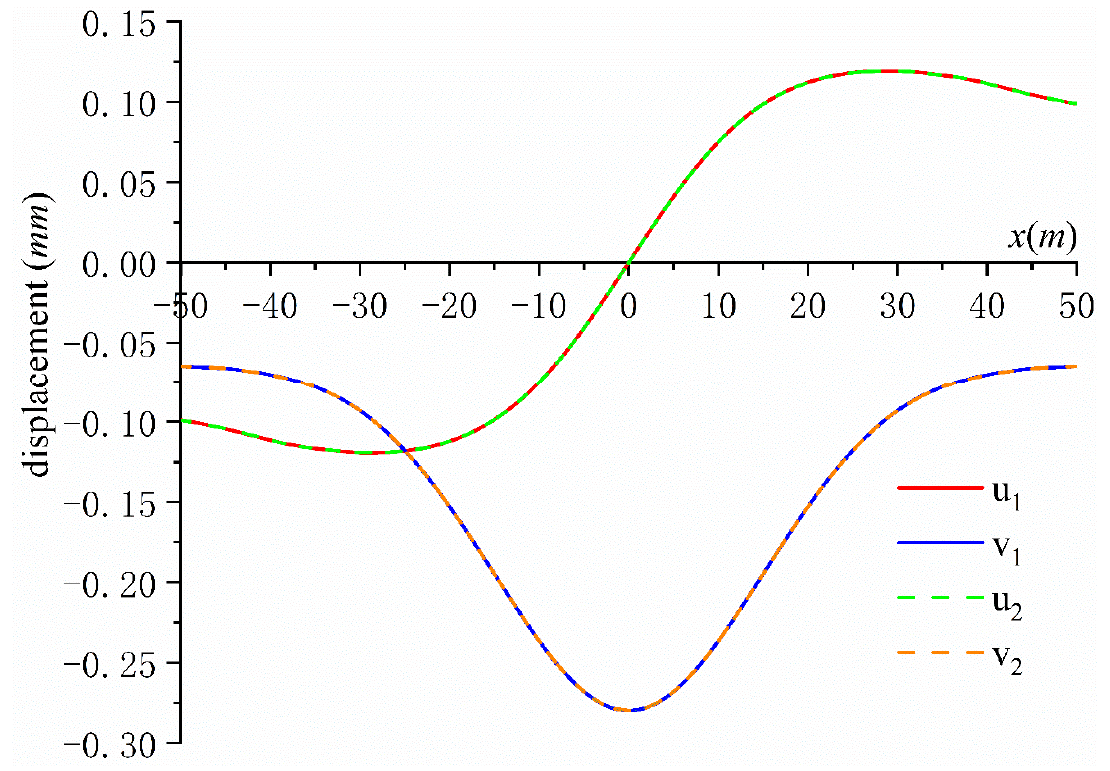
Figure 3. Verification of displacement continuity condition.